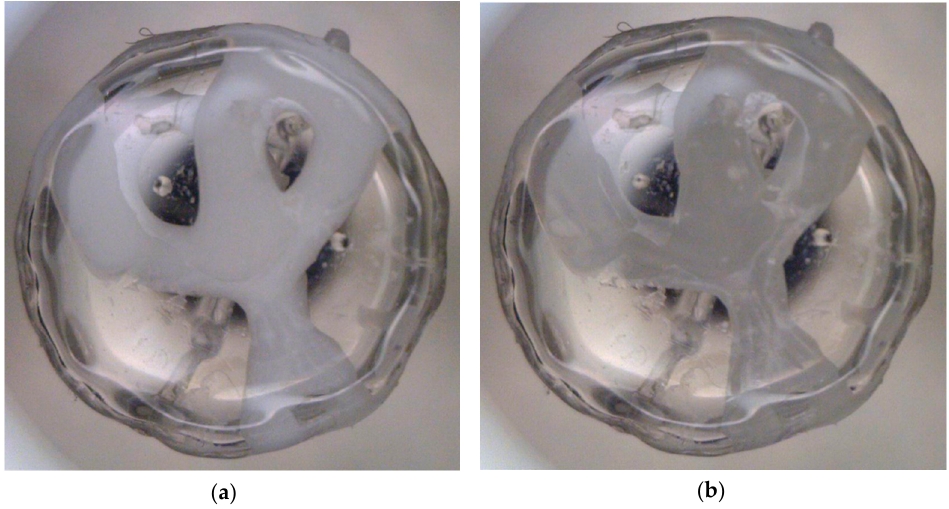
Figure 5. Images produced by the dynamic vapour sorption system of sample on 9 mm glass pan after ( a ) moisture content uptake or absorption and ( b ) drying phase, at 90% RH and 25 °C steady temperature.